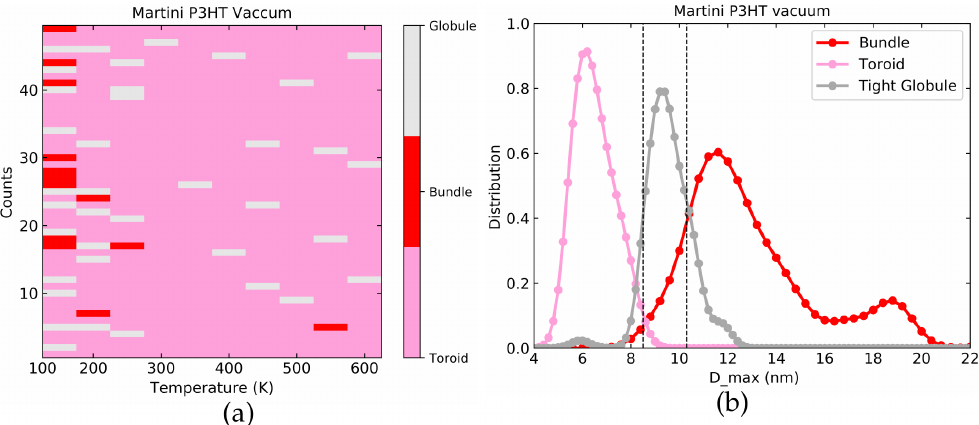
Figure 8. ( a ) Color coded final conformations at a range of temperature for 50 simulations for the Martini model of P3HT in a vacuum. ( b ) D max distributions used for toroid, globules, and bundles.